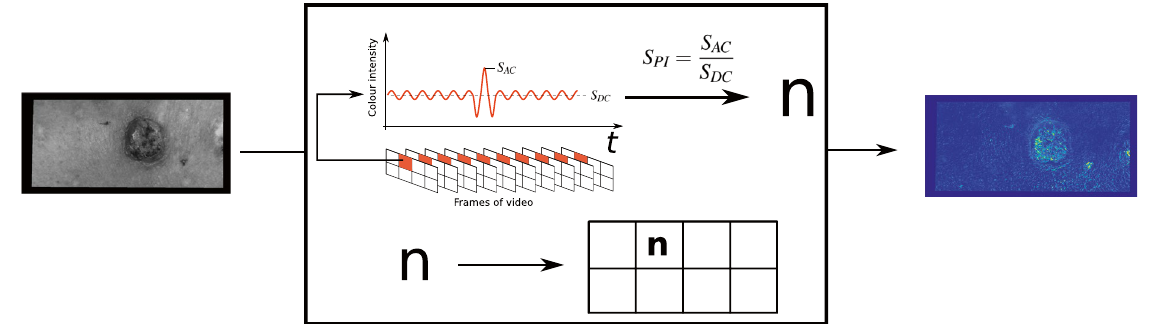
Figure 5. Illustration of the calculation of perfusion index for each single pixel in the video—in this example the period is the full time frame. Notice the marking of S AC and S DC .